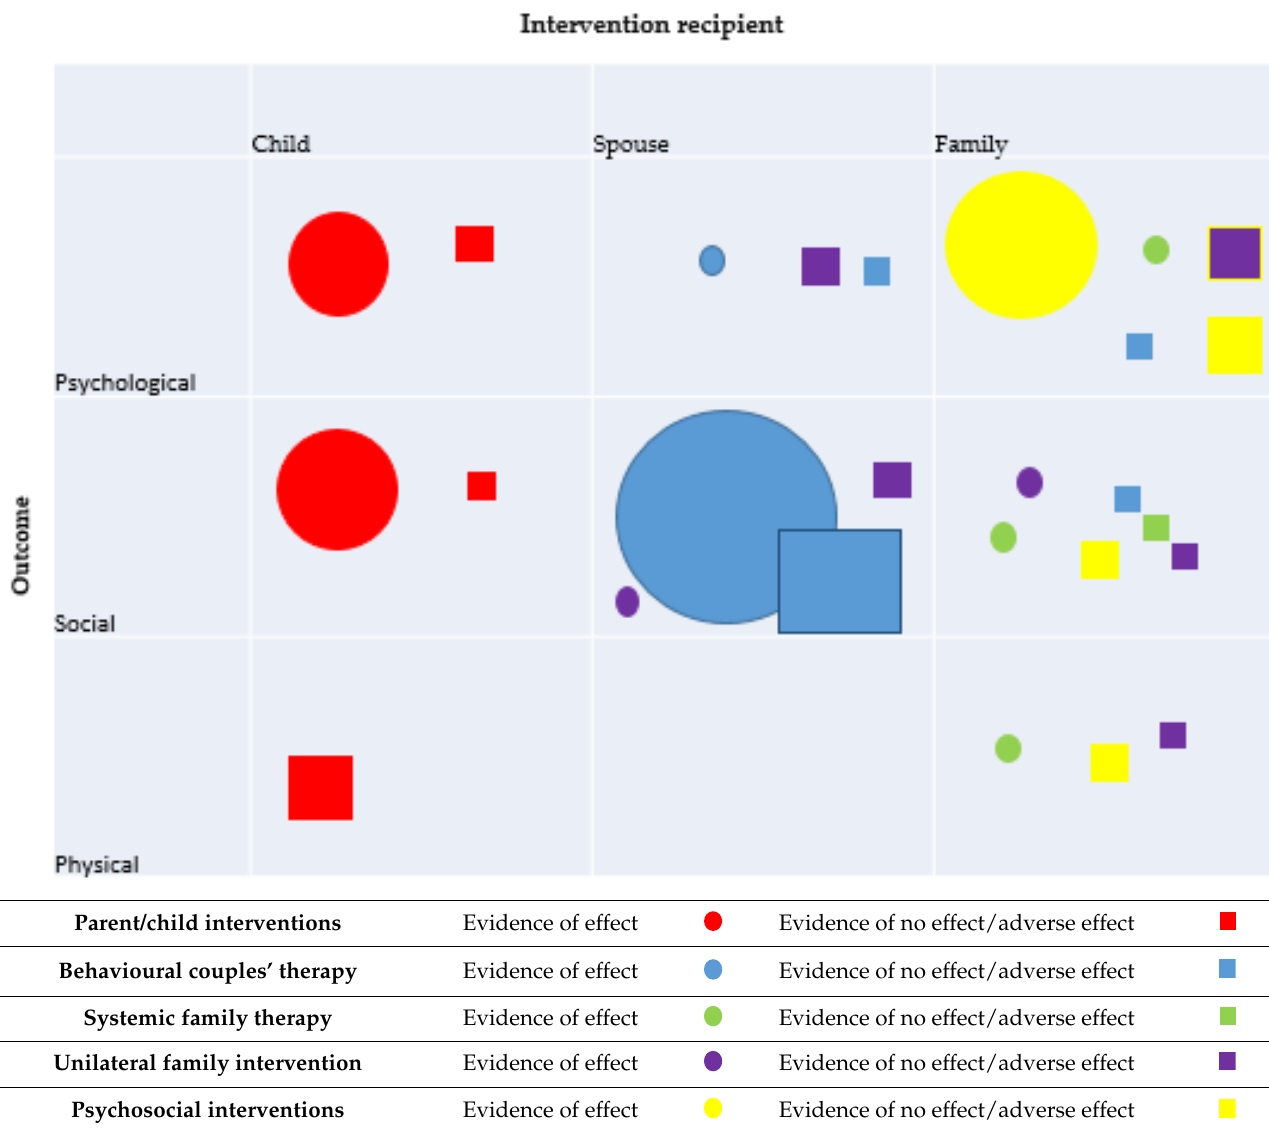
Table 1. Evidence and gap